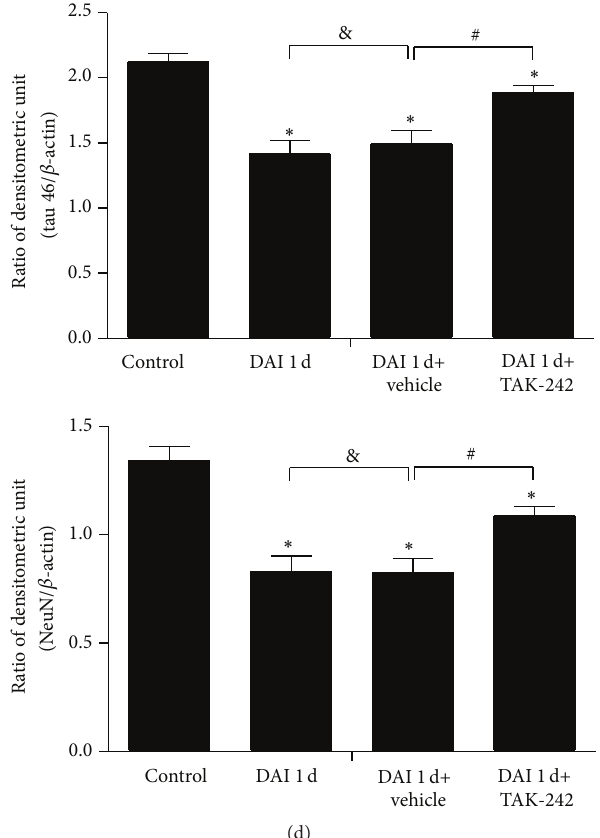
Figure 7: TLR4 inhibition attenuated neuronal and axonal injury. (a) Microtubule-associated protein tau immunoreactivity and neuronal nuclei protein (NeuN) immunoreactivity were assessed via immunohistochemistry in rat cortices in the control, DAI 1d, DAI 1d+vehicle, and DAI 1d+TAK-242 groups. Scale bar = 50 𝜇 m; enlarged figures scale bar = 20 𝜇 m. (b) The bar graphs show the results for tau and NeuN immunoreactivity, as determined via immunohistochemistry. Tau and NeuN immunoreactivity was assessed in 5 random fields (40x magnification) via immunohistochemical scores (IHS). (c) The expression of tau and NeuN was measured via western blotting. (d) The bar graphs show the results for tau and NeuN expression, as assessed via western blotting. Data are presented as the mean ± SD ( 𝑛 = 6 ; ∗ 𝑝 < 0.05 , compared with control group; # 𝑝 < 0.05 , & 𝑝 > 0.05 , compared with DAI 1d+vehicle